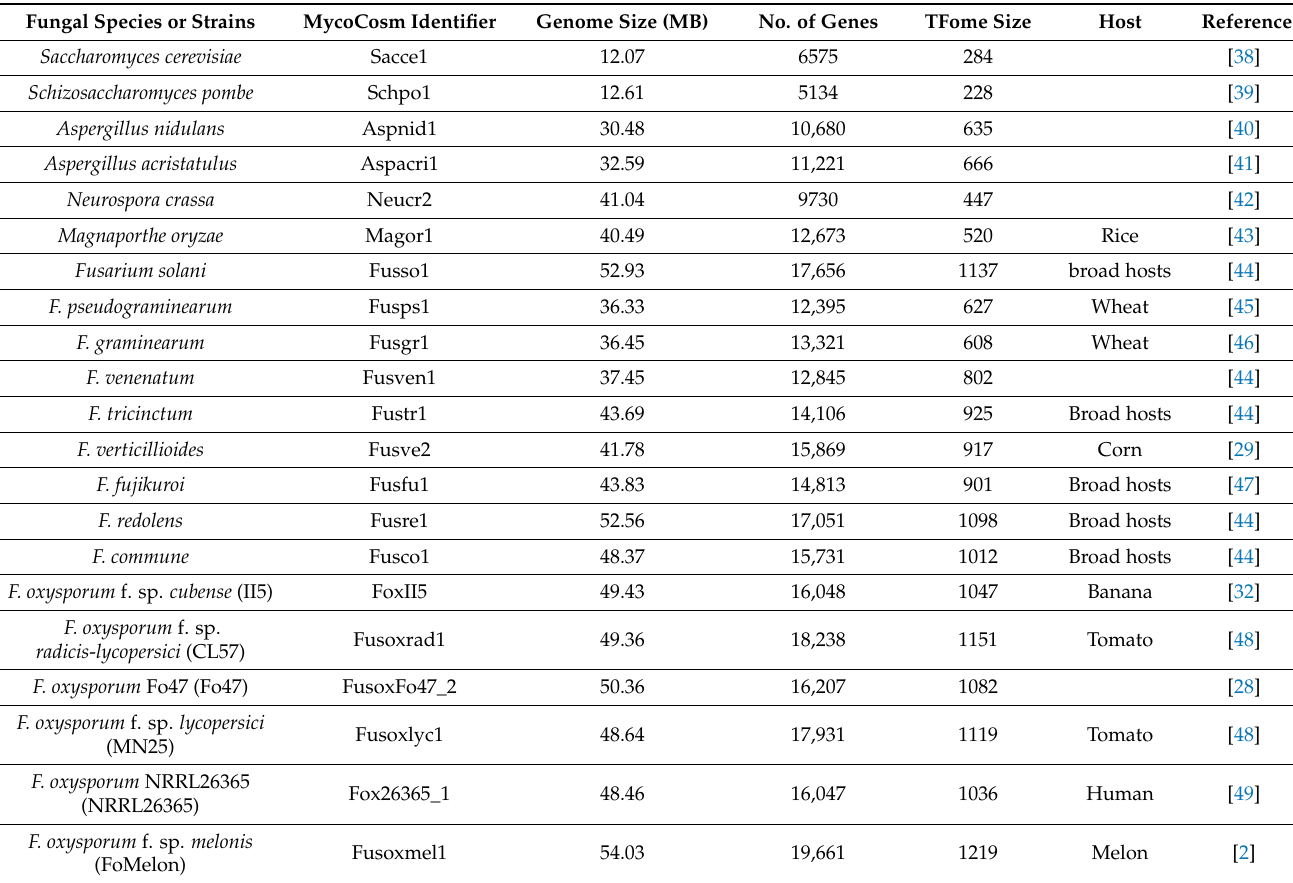
Figure 1. Phylogeny of fungal genomes included in this study. Both left and right phylograms were constructed by the concatenated alignment of randomly selected 500 single-copy orthologous proteins, followed by the maximum likelihood method with 1000 bootstraps. Left shows a phylogram of FOSC (represented by the reference genome Fol4287) together with the other 15 ascomycetes. The right shows a phylogram of members within FOSC, rooted by F. verticillioides (not shown). Only bootstrap values not equal to 100 are shown. Table 1. Fungal genomes used in this study.